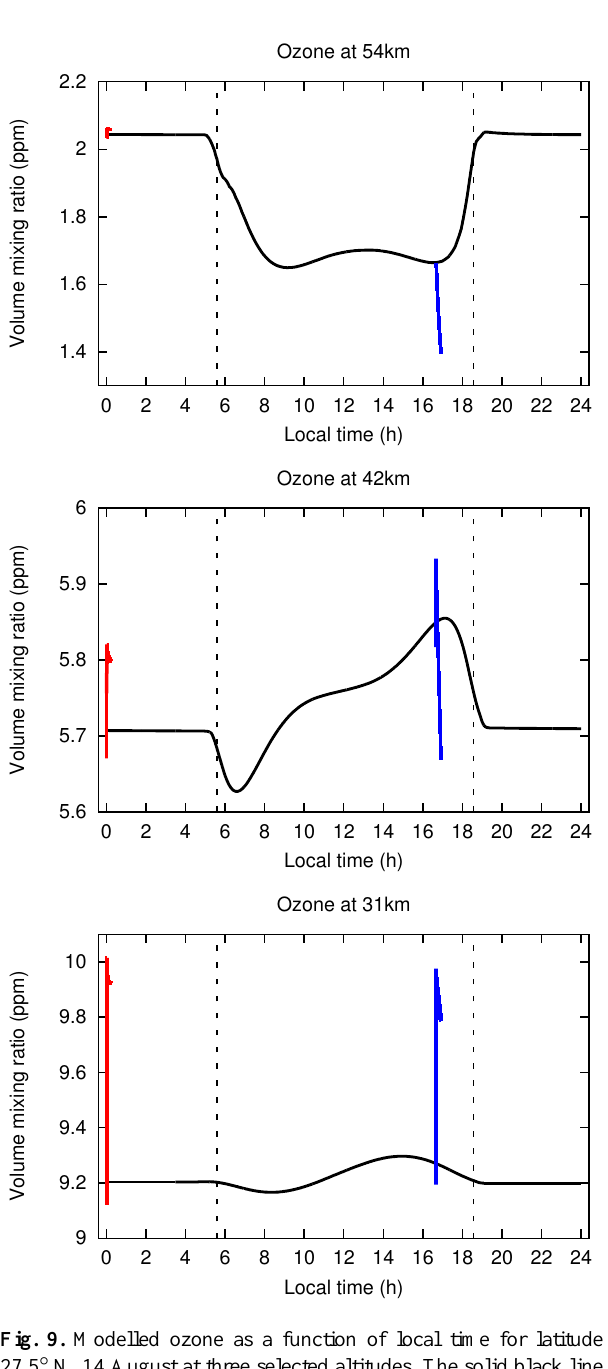
Fig. 9. Modelled ozone as a function of local time for latitude 27.5 ◦ N, 14 August at three selected altitudes. The solid black line shows the undisturbed diurnal cycle. Superimposed are the streamer ozone values for the night-time event (midnight, red), and the day- time event (16:41LT, blue). The dashed black lines depict sunrise and sunset,